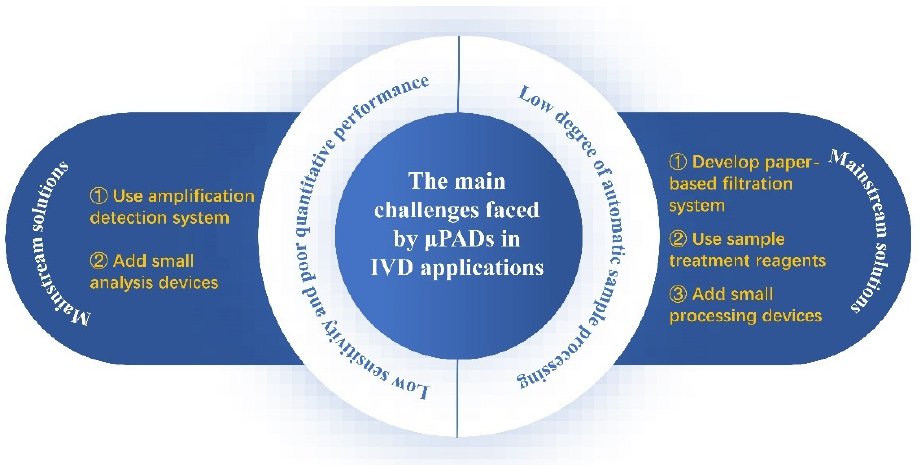
Figure 8. Main challenges and mainstream solutions for paper-based devices used in IVD.